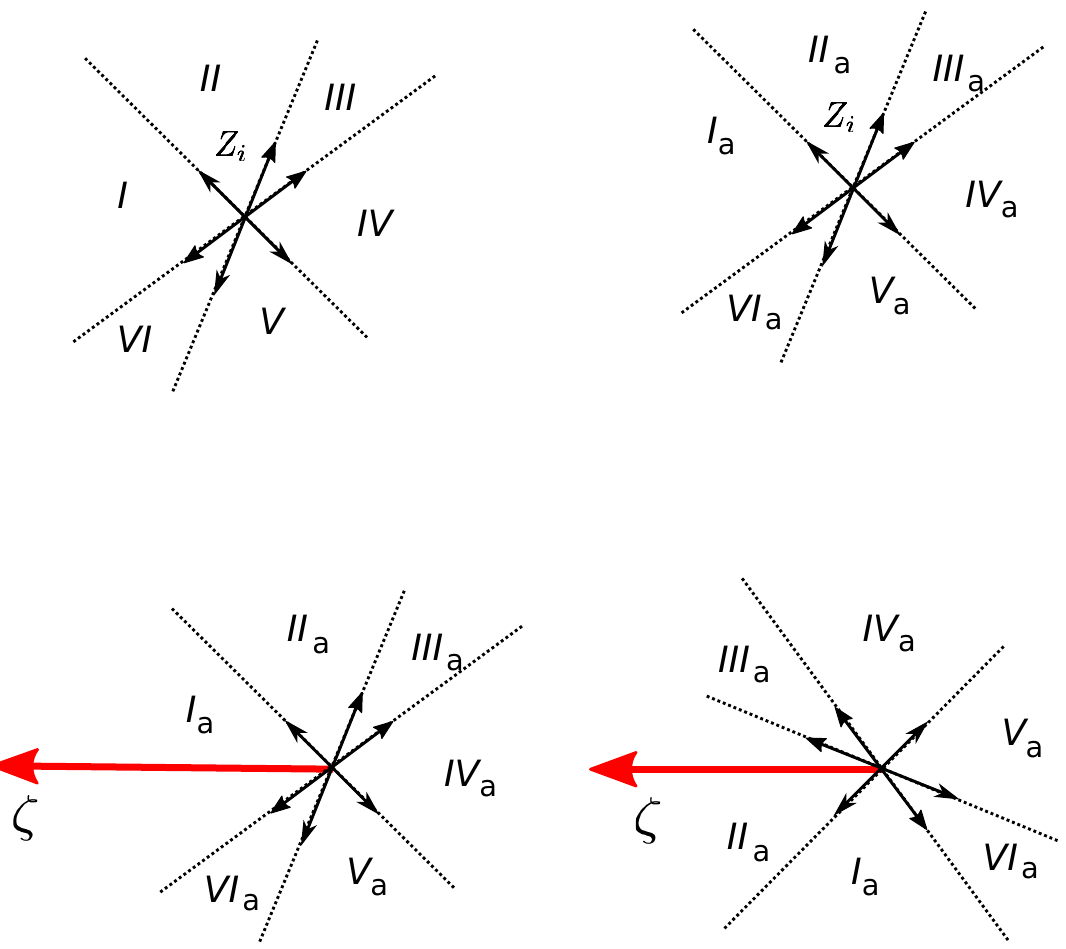
Figure 5 . Structure of framed BPS chambers in the Z -plane. up left: structure of chambers for an SCFT with integer valued R -charges. up right: generic structure of chambers: for SCFTs the index a is defined modulo ‘ , whenever the R -charges are valued in N /‘ , for asymptotically free theories a runs over the integers. down left/right: chambers related by crossing a wall of the second kind, corresponding to rotating out the charge γ on the a -th sheet of the covering. (1) the corresponding framed BPS particles is controlled by the position of arg ζ relative to